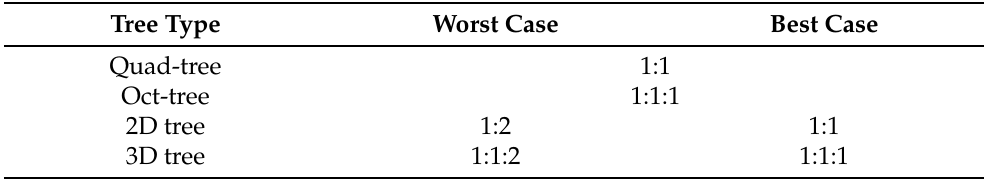
Table 2. Aspect ratios of the sub-cells generated by quad-tree, oct-tree, and kd-tree subdivision. The initial element shape is assumed to be square (2D) or cubic (3D).